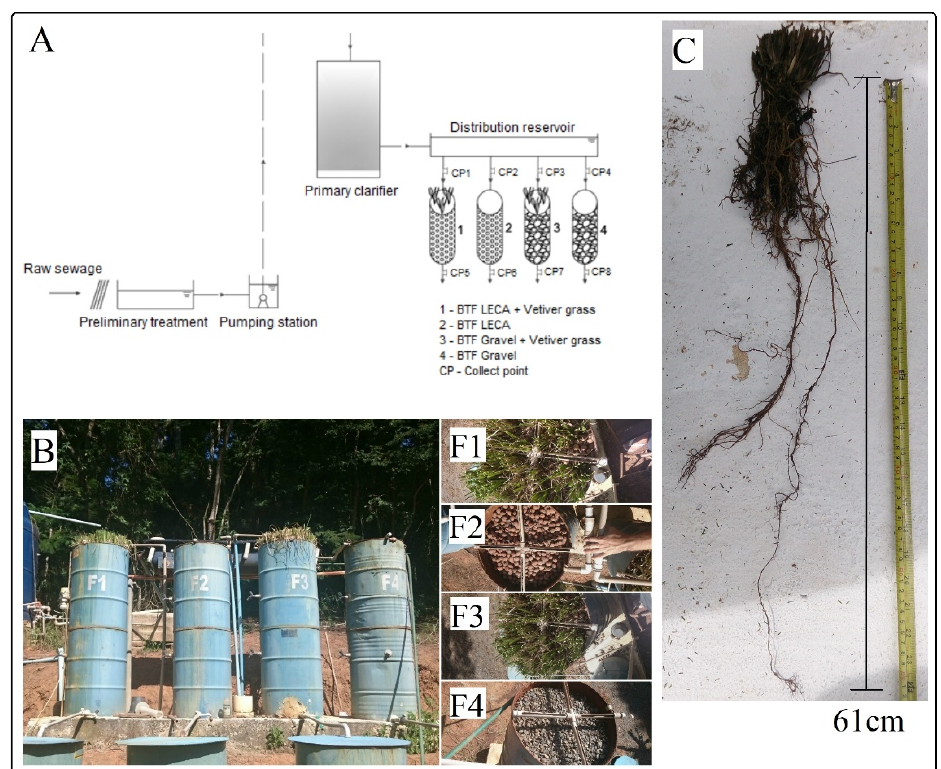
Figure 1. Flowchart of the experimental unit ( A ) and a digital image (taken after a shallow cut in the vegetation) of the BTF of gravel and LECA with and without vetiver ( B ). F1: BTF with LECA+ vetiver; F2: BTF with LECA; F3: BTF with gravel + vetiver; F4: BTF with gravel. ( C ) Vetiver root extracted from F3.